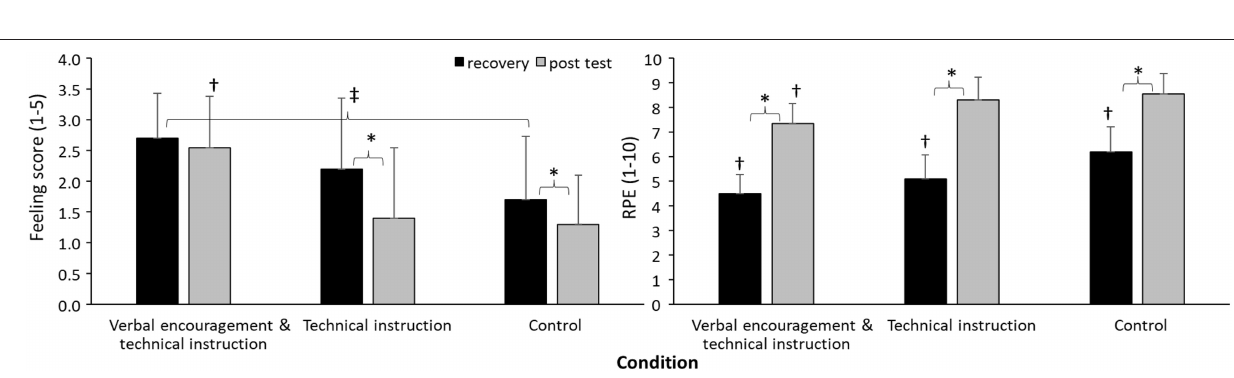
FIGURE 2 | Mean ( SD ) for rate of perceived exertion (RPE) and feeling score under recovery and at post test of a small-sided passing game in the three conditions. *indicates a significant difference from 1st to 2nd set at a p < 0.05 level. † indicates a significant difference with all other conditions for this test at a p < 0.05 level. ‡ indicates a significant difference between these two conditions for this test at a p < 0.05